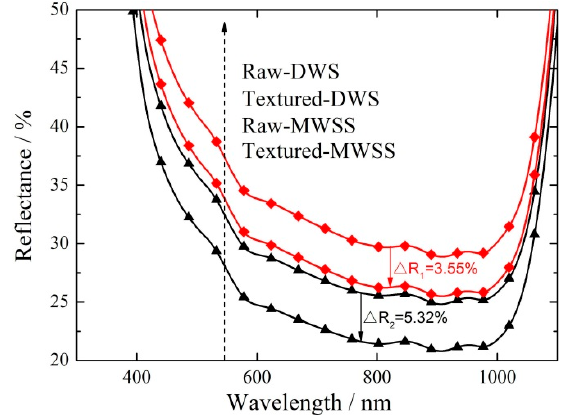
Figure 2. Reflectance curves of MWSS wafer and DWS wafer before and after acid texture.